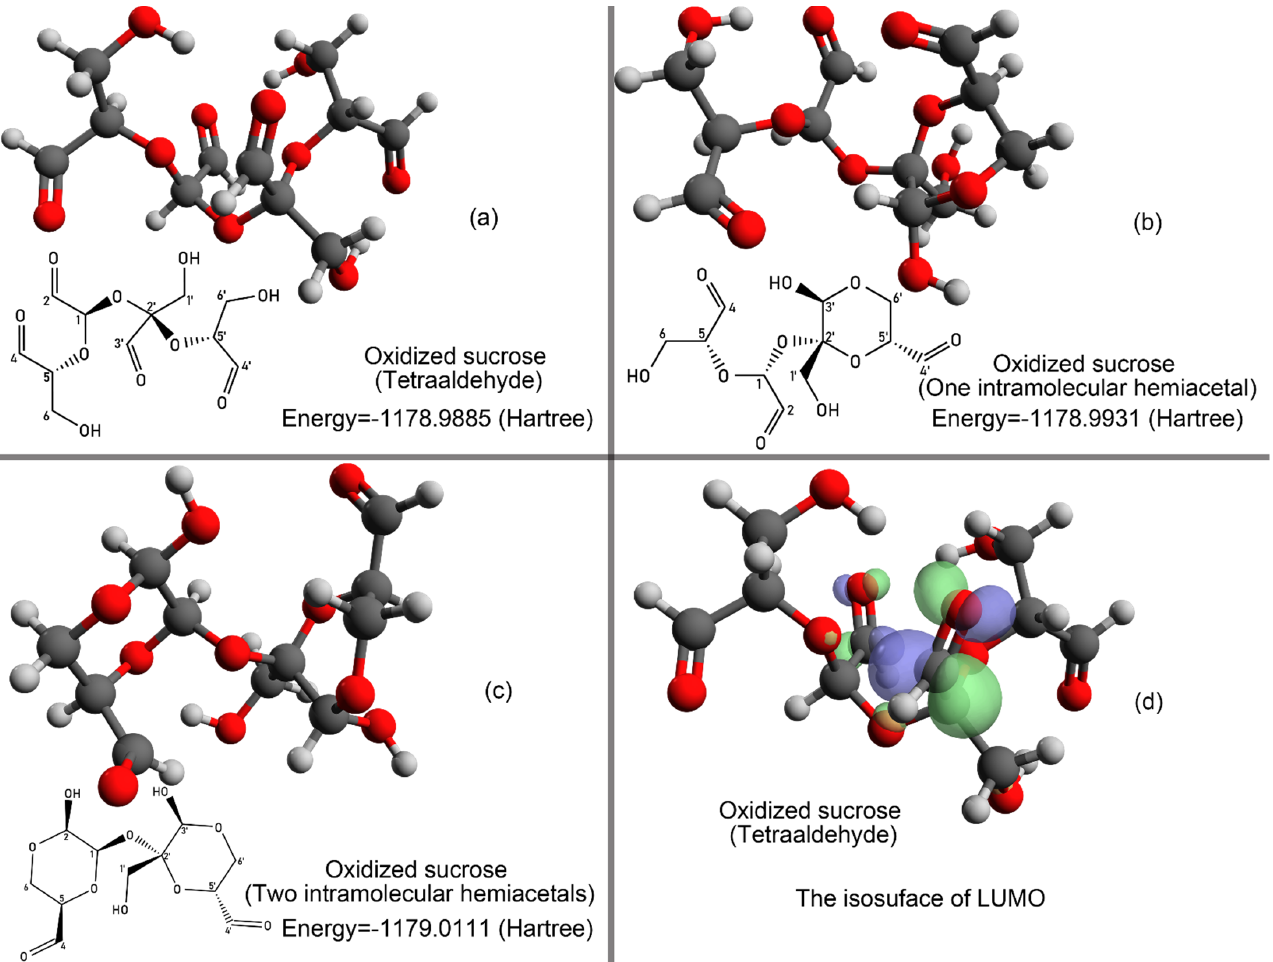
Figure 9. Oxidized sucrose isomers and their energies ( a – c ) and visualized LUMO isosurface ( d ) of tetraaldehyde oxidized sucrose.